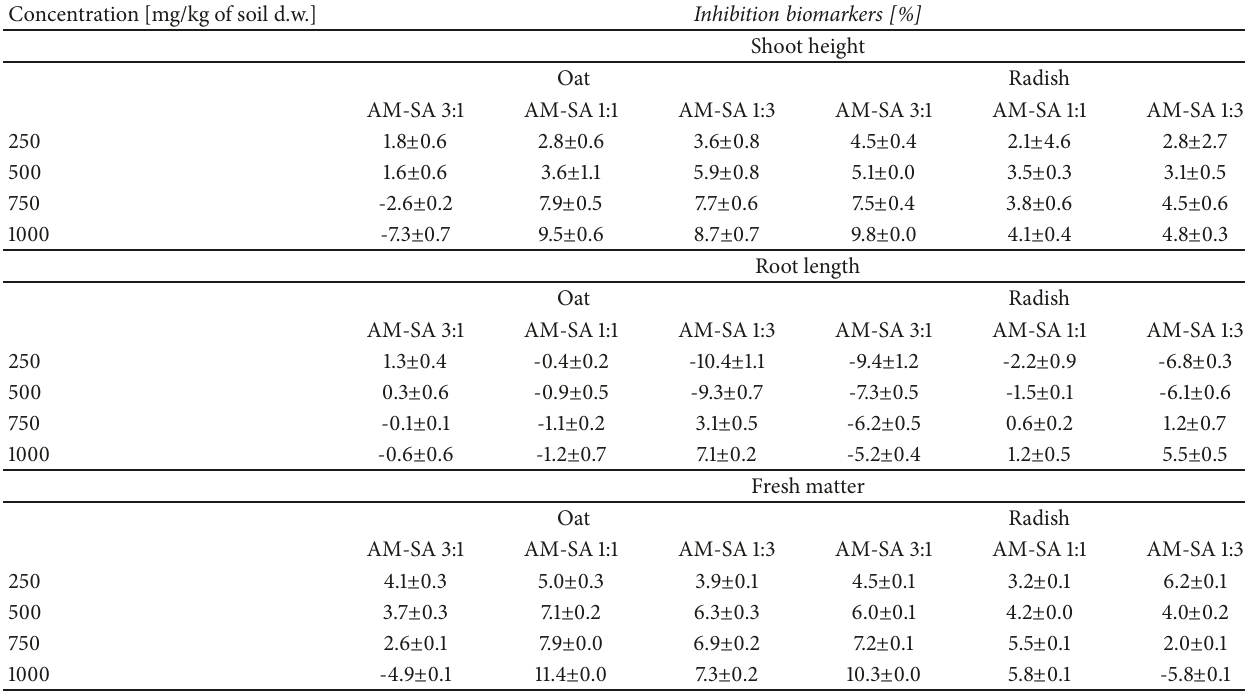
Table 3: Effect of AM-SA 3:1, AM-SA 1:1, and AM-SA 1:3 hydrogels on the shoot height, root length, and fresh matter of oat and radish seedlings (mean ± SD). Concentration [mg/kg of soil d.w.]